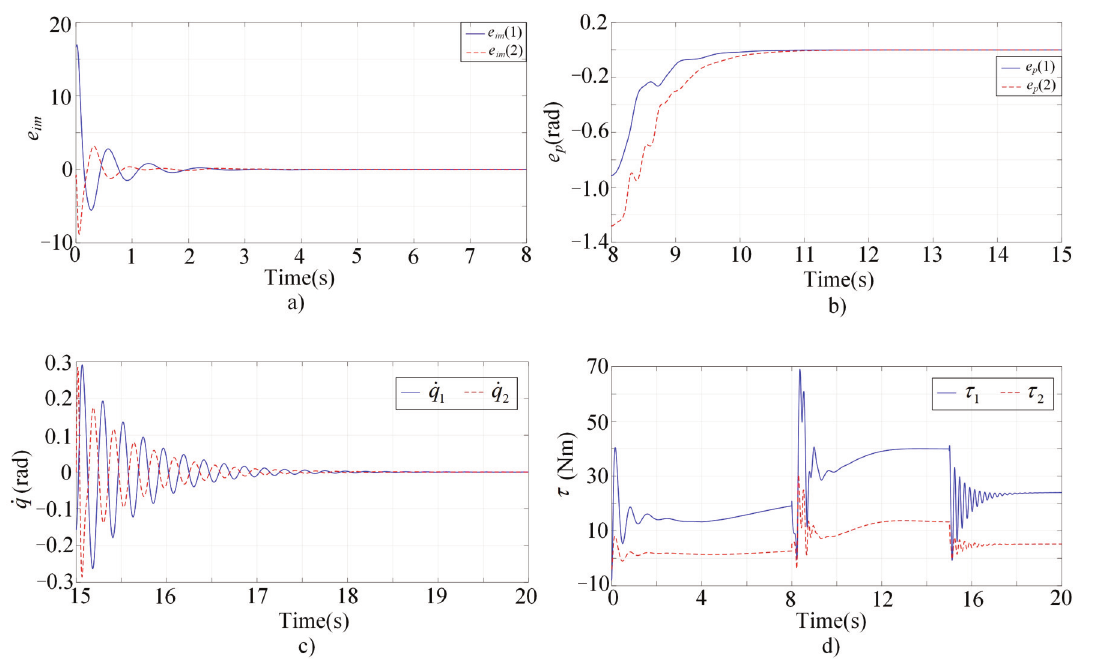
Figure 6. Simulationresults of the adaptive control. ( a ) The impedance errors; ( b ) The tracking errors; ( c ) The convergence of the ˙ q to zero; ( d ) The control